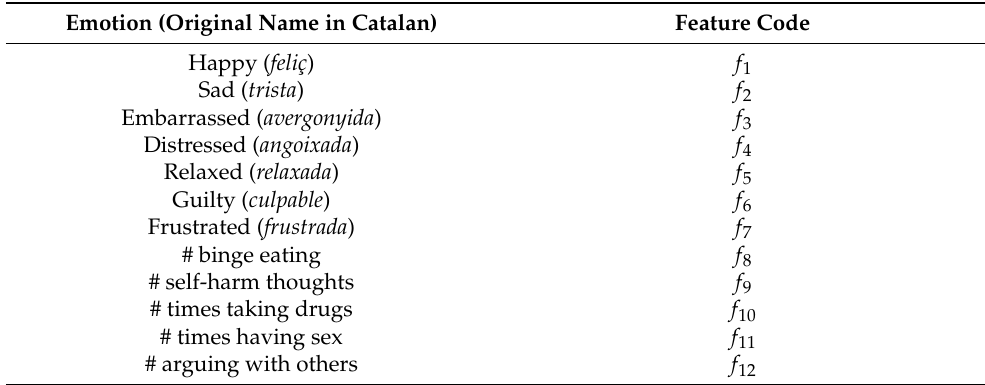
Table 1. List of emotions and daily activities collected through the Sinjur app, together with the associated